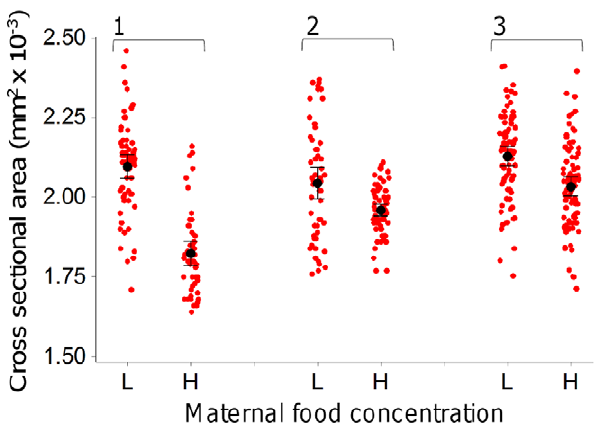
Figure 5. Maternal food availability affects egg size. Jitter plot showing the cross sectional area of eggs isolated from mothers grown at high (H) and low (L) maternal food concentrations in three independent experiments (1–3). The mean cross sectional area ( 6 95% confidence interval) is also shown for each treatment. In all cases High maternal food availability was 10% w/v E. coli . Low maternal food availability was a combination of 2.5% and 0.125% w/v E. coli for assay 1, 0.3125% w/v E. coli for assay 2 and 1.25% w/v E. coli treatments for assay 3. Mean cross sectional areas were calculated from 49–83 eggs/ treatment (median